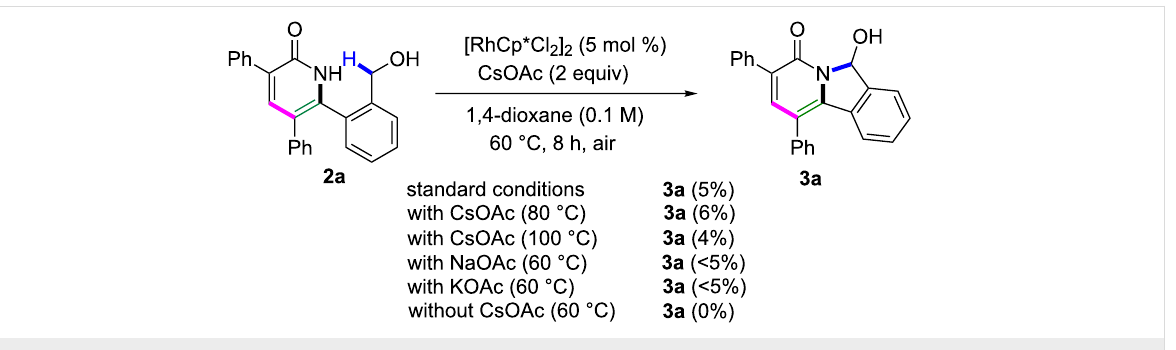
Scheme 3: Control